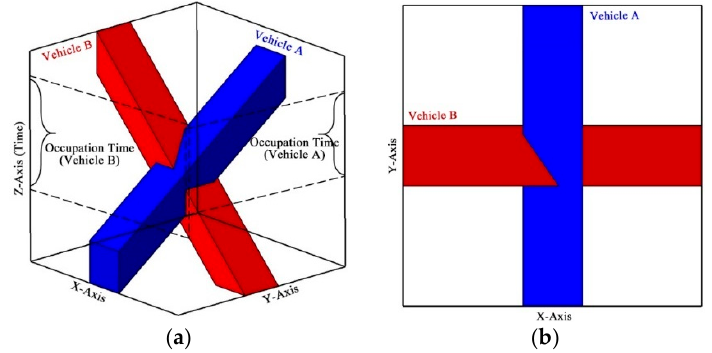
Figure 4. Diagram of a collision from combined spatio-temporal domains. ( a ) 3D axonometric view; ( b ) 2D vertical view.